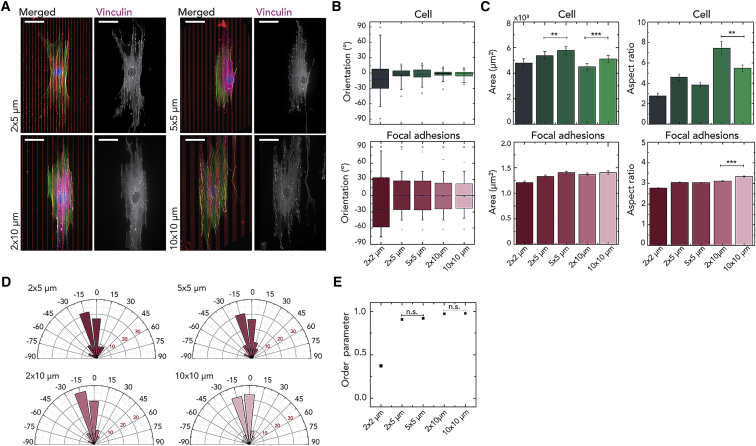
Influence of Line Width on the Cellular and FA Organization(A) Representative immunofluorescence images of myofibroblasts on fibronectin lines (red) of various and inter-line spacings (w = 2, 5, and 10 μm and s = 2, 5, and 10 μm) stained for the actin cytoskeleton (green), nucleus (blue), and FAs (magenta). Scale bars: 50 μm. The width of the lines has no effect on the cell orientation, although it affects cell area and aspect ratio (B and C). The corresponding FAs are also not affected by line width (B and D).(B) Boxplots represent the mean with 5th–95th percentile range, with the whiskers indicating the outliers of the cell and FA orientation.(C) The mean ± SEM of the cellular and FA area and aspect ratio. ∗p < 0.05; ∗∗p < 0.01; ∗∗∗p < 0.001. The data reported come from three independent samples, and at least 20 cells were considered per condition.(D) The angular histogram of the FA orientations, where 0° represents the direction of the lines.(E) Measurements of the cell orientation order parameter Θ versus the line dimensions (width × spacing μm). The values of Θ range within 0–1, corresponding to random alignment when Θ = 0 and perfect alignment when Θ = 1. The results are from three independent experiments. At least 60 cells were considered per condition.